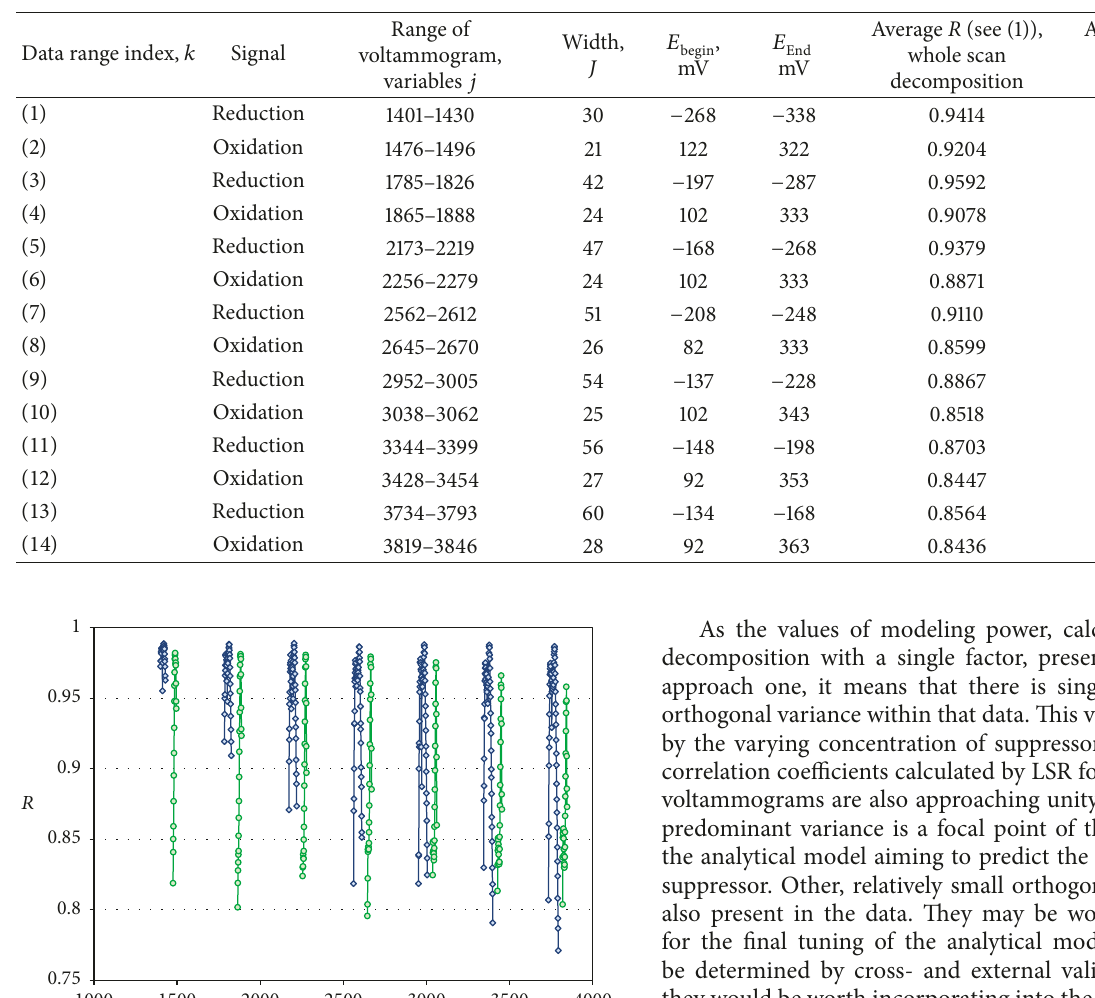
Table3:Preliminaryestimationoftherangesofpointsofstaircasevoltammogram,variables 𝑗 ,ofFigure1 selectedbasedonresultsofFigure2. The potentials are expressed versus 𝐸 reference electrode. Cu 2+ / Cu